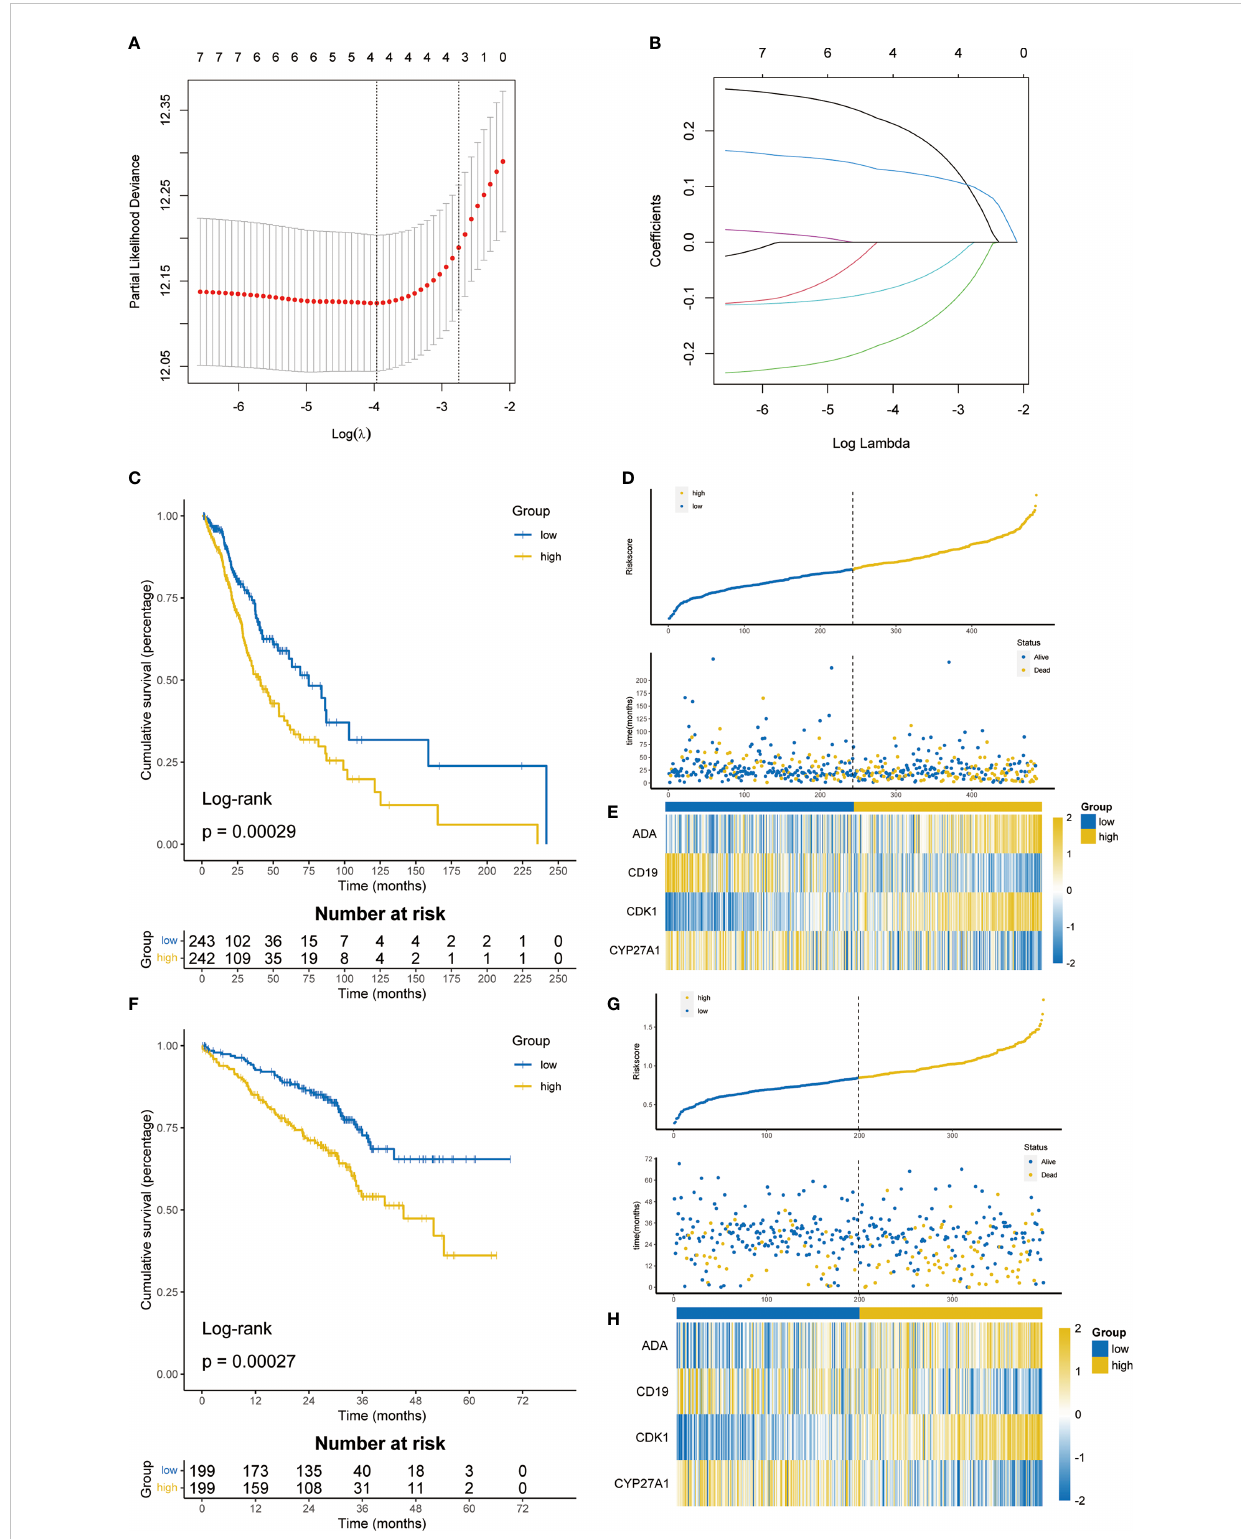
FIGURE 3 Construction and validation of T cell proliferation signature. (A) 10-fold cross-validation in the LASSO model. (B) Coef fi cient distribution of key T cell proliferation regulators. (C) The K-M survival analysis showed the difference of prognosis in TCGA cohort. (D) Distribution of risk score and survival status in TCGA cohort. (E) Heatmap showing 4 T cell proliferation regulators in TCGA cohort. (F) The K-M survival analysis showed the difference of prognosis in GSE72094. (G) Distribution of risk score and survival status in GSE72094. (H) Heatmap showing 4 T cell proliferation regulators in